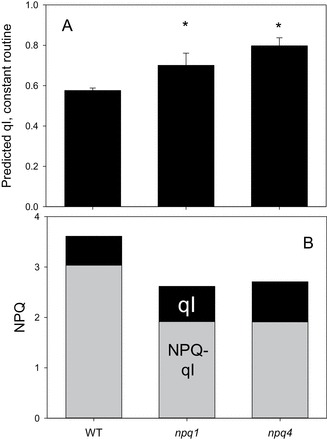
(A) Amplitude of qI for WT, npq1, and npq4 leaves. This was derived from the relationship between NPQ and qPd in nigericin-infiltrated leaves (see text and Supplementary Fig. S4 at JXB online for more detail). Error bars represent the SEM (n=5). (B) Proportions of relative amplitude of photoinhibitory NPQ (qI) and non-photoinhibitory NPQ (NPQ–qI) for WT, npq1, and npq4 Arabidopsis plants. See in text for details. A single asterisk is used to signify this significant difference between mutants and WT plants, with a double asterisk representing a significant difference between npq1 and npq4 plants (P<0.05).